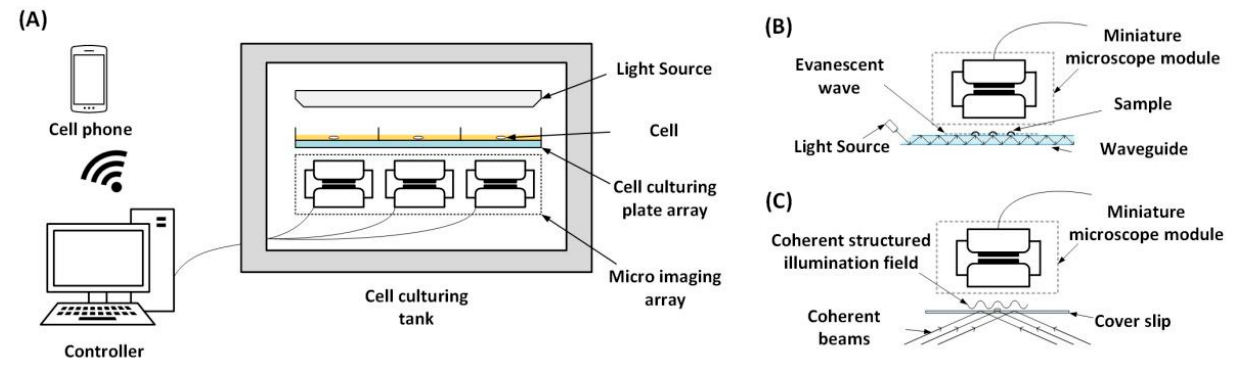
Figure 10. Potential applications based on the proposed miniature microscope. ( A ) Real-time microscopic wireless observation of the enclosed cell culturing process. ( B ) Scheme of a low-cost total internal reflection miniature microscope. ( C ) Scheme of a low-cost structured illumination miniature microscope for enhanced